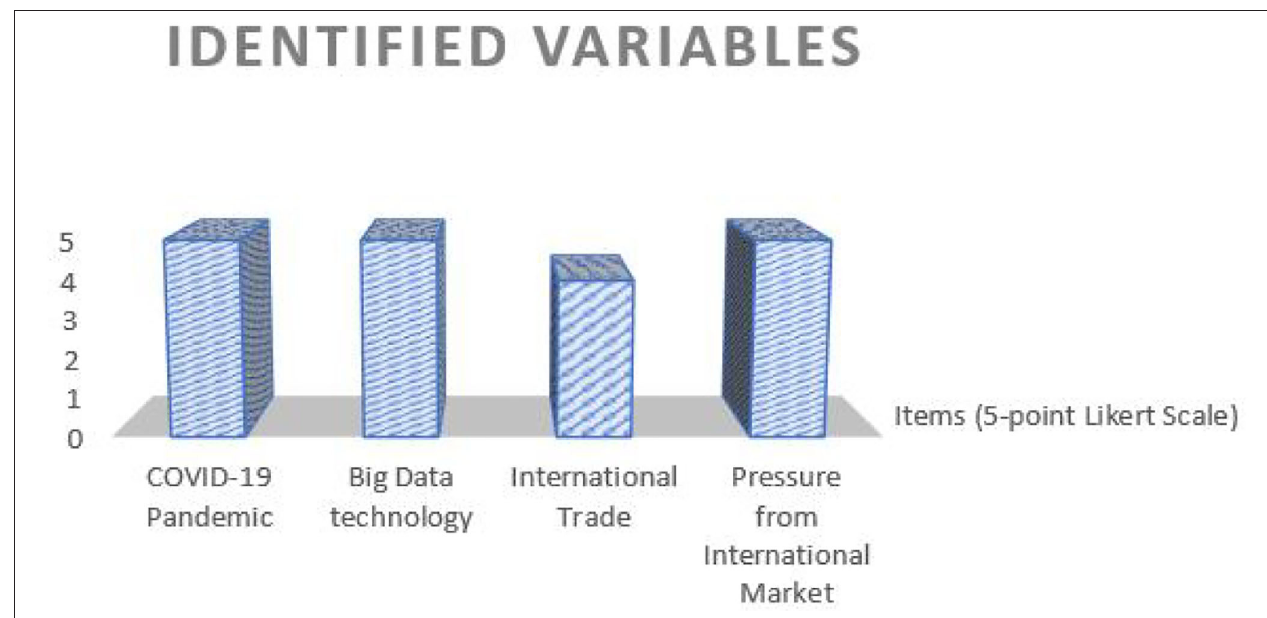
FIGURE 2 | Graphical representation of the identified variables ( X -axis, variables identified in the study; Y -axis, rating